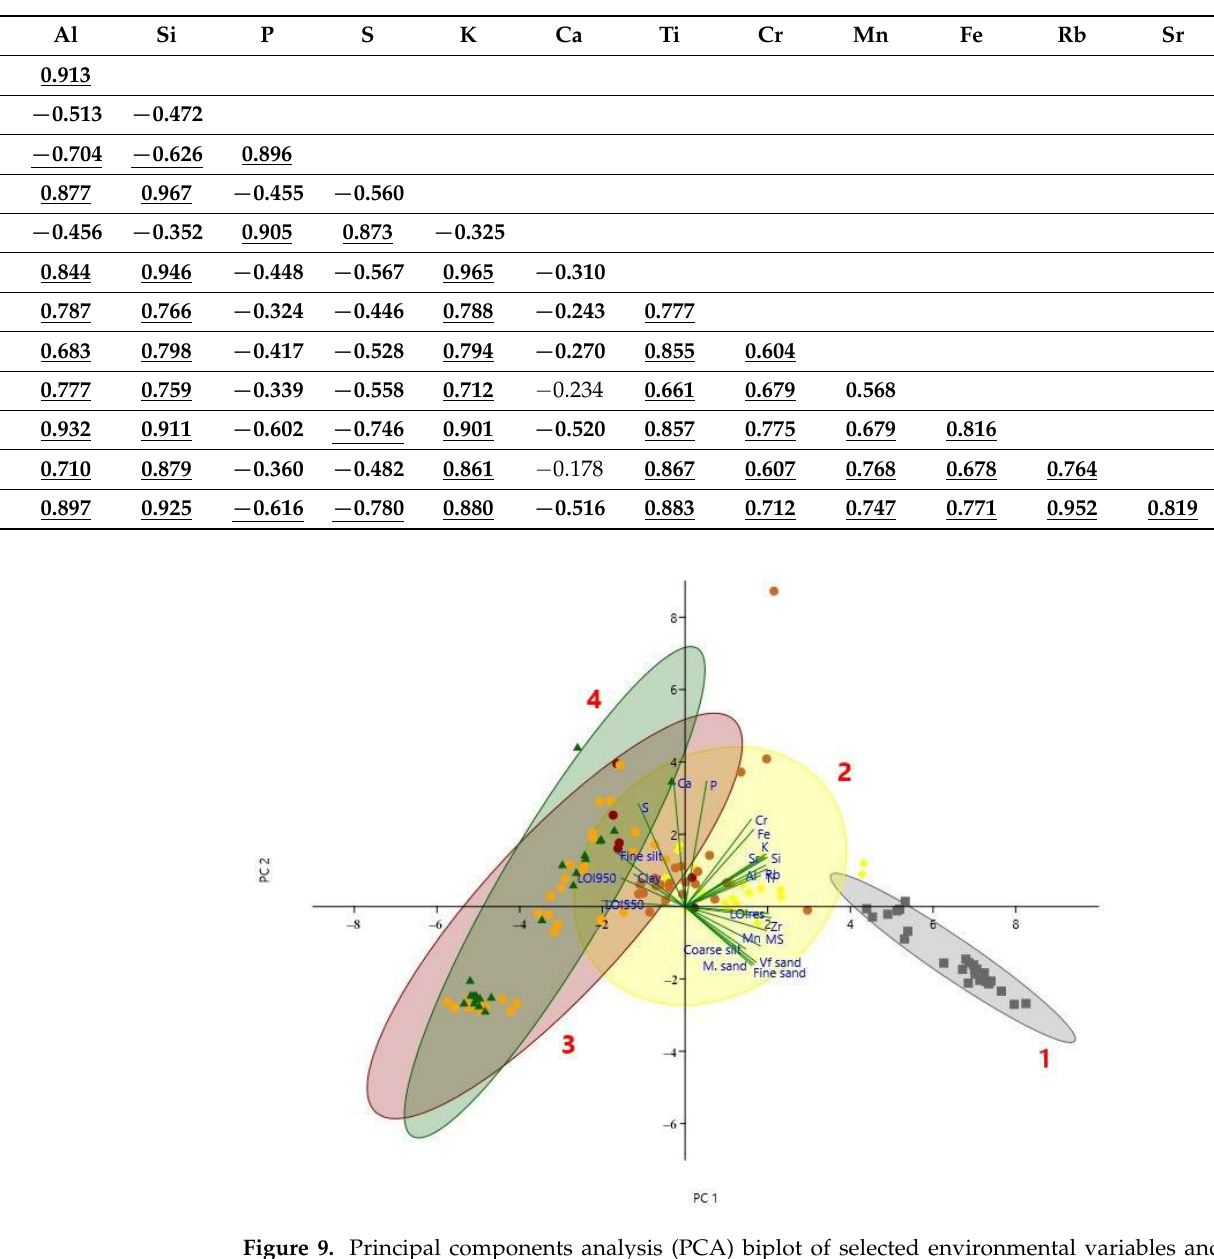
Table 5. Spearman’s rank correlation coefficients matrix between the concentrations of analysed elements. Bold fond shows a significant correlation at the 0.01 level (2-tailed). The underlined correlation coefficients are higher than 0.6.